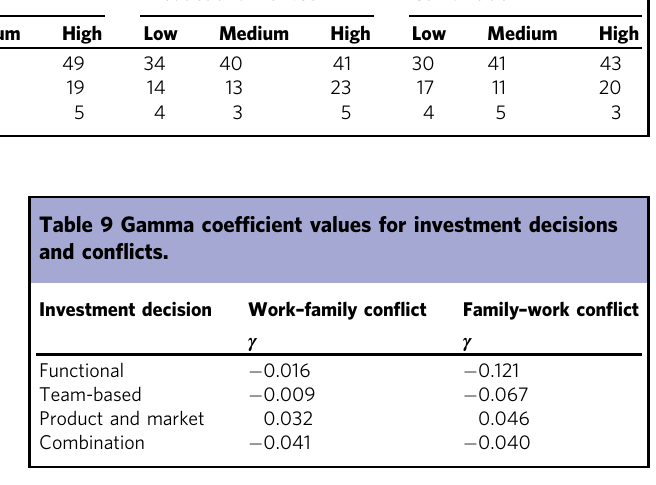
Table 8 Family – work con fl ict and investment decisions intersection set number of elements. Family – work con fl ict